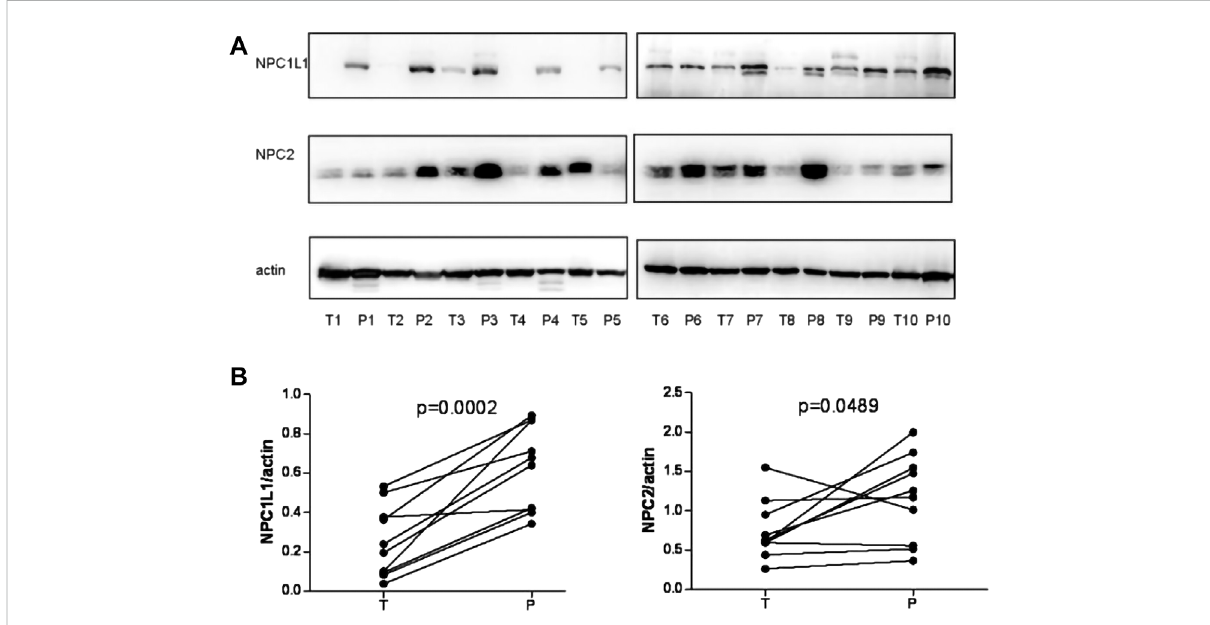
FIGURE 7 (A) NPC1L1 and NPC2 expressions were detected in 10 pairs of HCC tissues (T) and peritumoral tissues ( p ) by Western blot analysis. The expressions of NPC1L1 and NPC2 were signi fi cantly decreased in HCC tissues. Meanwhile, the mRNA expressions of NPC1L1 and NPC2 expression levels were also decreased in HCC tissues compared with peritumoral tissues. (B) Quantitation of proteins from Western blot analyses shows that both NPC1L1 and NPC2 expressions were signi fi cantly reduced in the HCC tissue (T) (Chen et al., 2018).